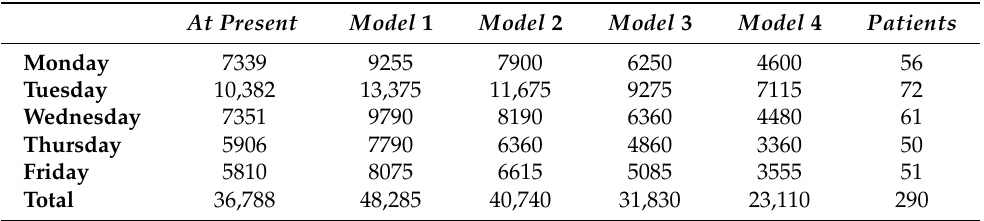
Table 2. Total waiting minutes over the different ready times considered provided by the deterministic